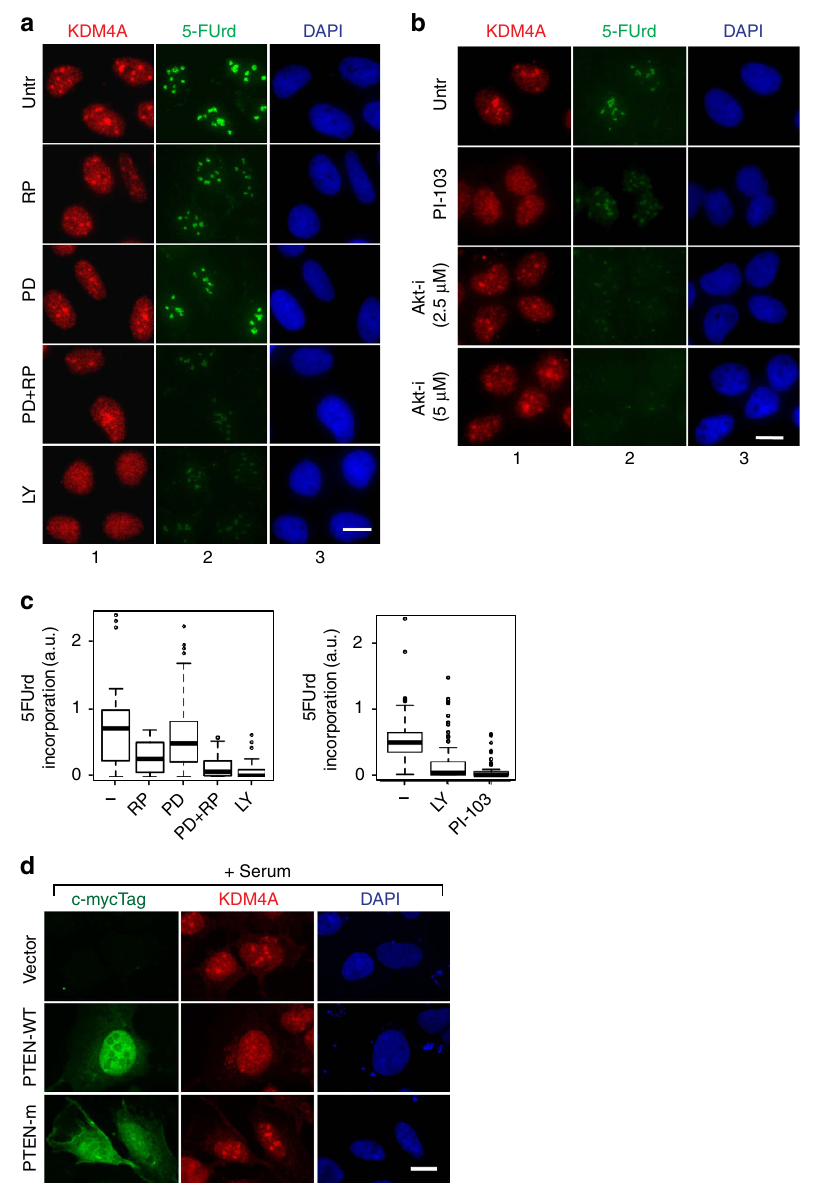
Figure 7 | PI3K pathway controls nucleolar localization of KDM4A. ( a ) U2OS cells were serum starved for 24h. Starved cells were incubated for 30min with MAPK inhibitor PD98059 (PD), mTOR inhibitor rapamycin (Rapa), or PI3K inhibitor LY294002 (LY) or a mixture of mTOR and MAPK inhibitors (PD þ Rapa) or DMSO as a control (Untr) and refed with serum in the presence of 5-FUrd and the respective inhibitors. Thirty minutes after serum addition cells were fixed and analysed by indirect immunofluorescence using antibodies specific to human KDM4A (Ab1, panels 1) and 5-FUrd (panels 2); nuclear DNA was stained by DAPI (panels 3). Scale bar, 5 m M. ( b ) U2OS cells were serum starved for 24h. Starved cells were incubated for 30min with PI3K inhibitor PI-103, AKT inhibitor AKTVIII (AKT-i), or DMSO (Untr) and refed with serum in the presence of 5-FUrd and the respective inhibitors. Thirty minutes after serum addition cells were fixed and analysed by indirect immunofluorescence using antibodies specific to human KDM4A (Ab1, panels 1) and 5-FUrd (panels 2); nuclear DNA was stained by DAPI (panels 3). ( c ) Quantification of 5-FUrd staining shown in a and b done as in Fig. 2e. The effect of inhibitors or combination of inhibitors are all significant ( P value o 10 4 , Wilcoxon test), except treatment with PD alone. Note that no incorporation could be measured upon AKT inhibition. The median values are shown as horizontal lines, outliers are shown as open circles; n ¼ 3. ( d ) U2OS cells were transfected with an expression vector encoding c-myc-tagged PTEN either wild-type (PTEN-WT) or mutated for its lipid phosphatase activity (PTEN-m). 24h following transfection, cells were serum starved for 24h and refed with serum containing 5-FUrd. Cells were fixed and analysed by indirect immunofluorescence using antibodies specific to c-myc Tag to detect overexpressed PTEN (panels 1); KDM4A (panels 2); nuclear DNA was stained by DAPI (panels